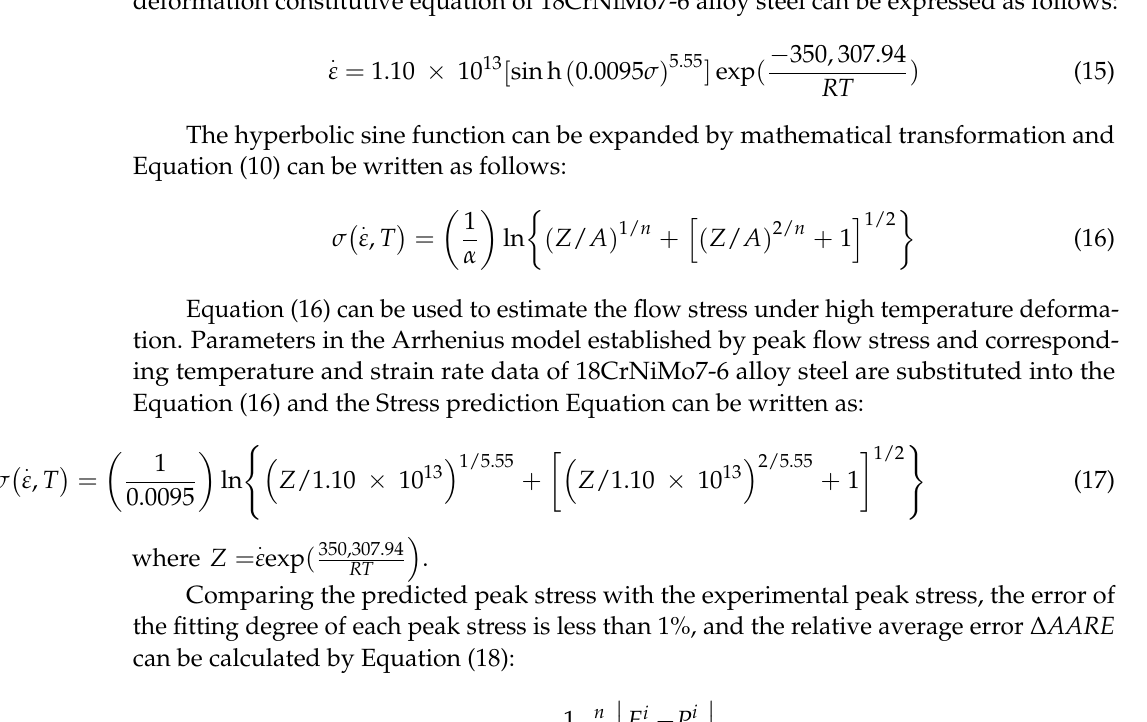
Figure 4. Relationship of ( a ) ln ε ̇ -ln σ ; ( b ) ln ε ̇ - σ ; ( c ) ln ε ̇ -ln[sinh ( ασ )] ; ( d ) ln [ sinh ( ασ )] -1/ T ; ( e ) ln Z -ln [ sinh ( ασ )].